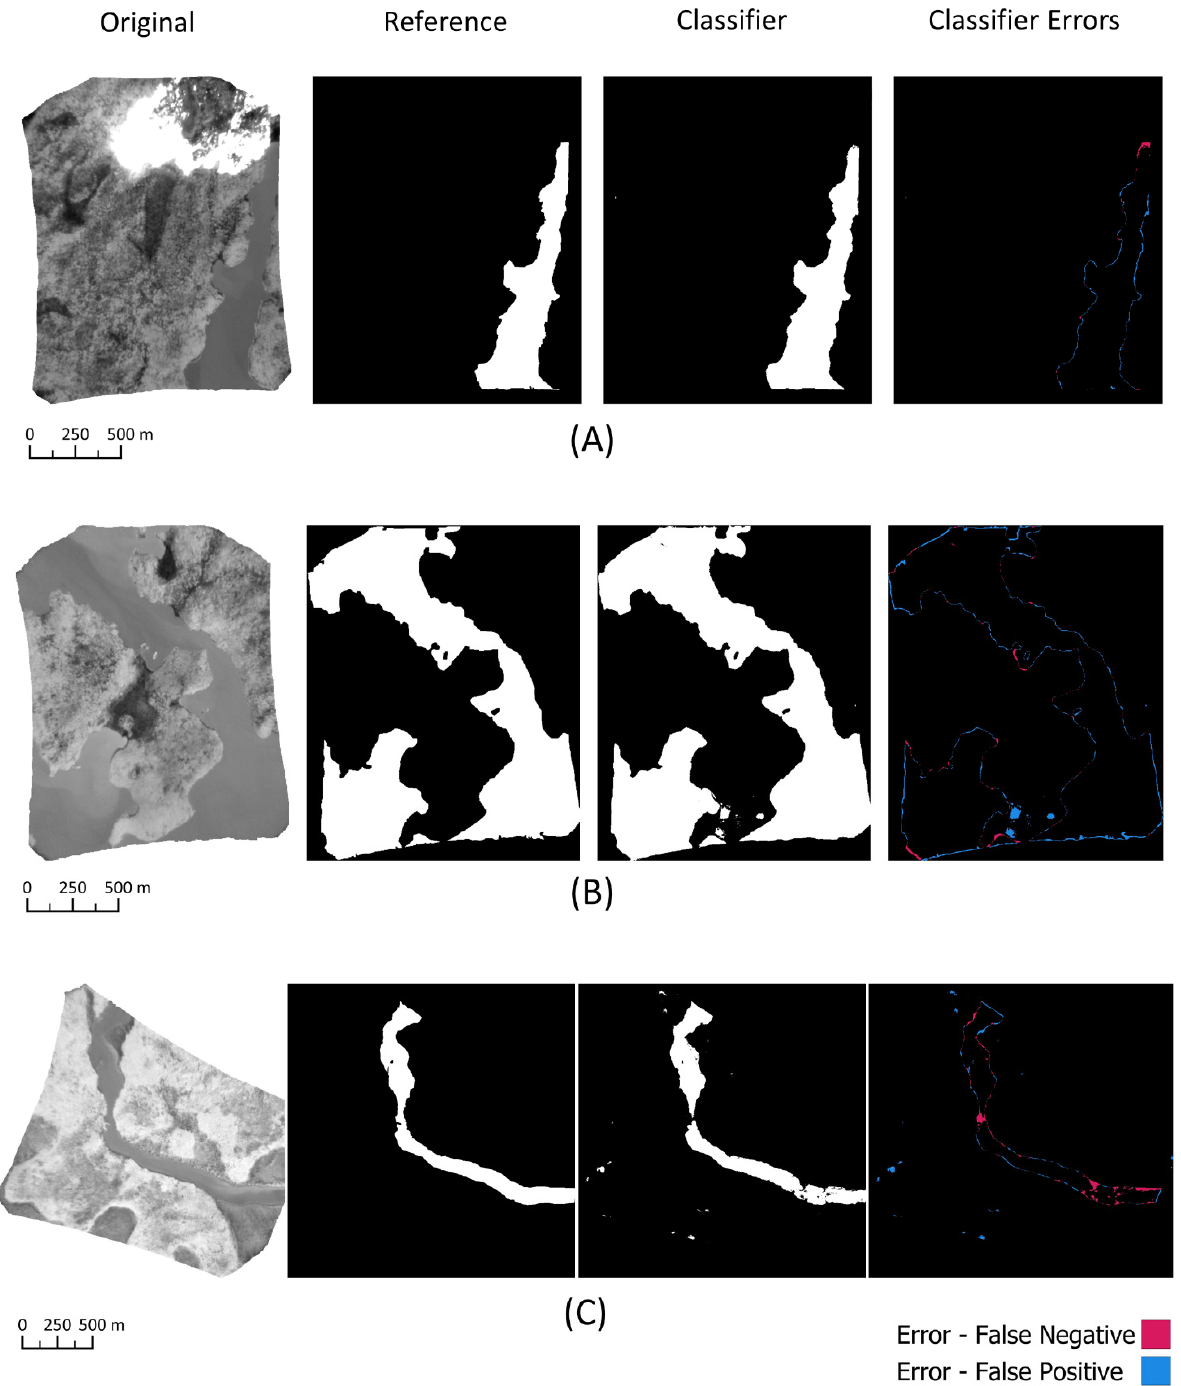
Figure 10. Sample segmentation results using the 91-feature RF classifier trained with 50 images. ( A ) Overall strong accuracy, even in the presence of flaming combustion close to the shoreline, without the directional skewing common in static GIS data output; ( B ) noise and larger false positive blobs occurred in many images; ( C ) weaker performance near narrower waterbodies.